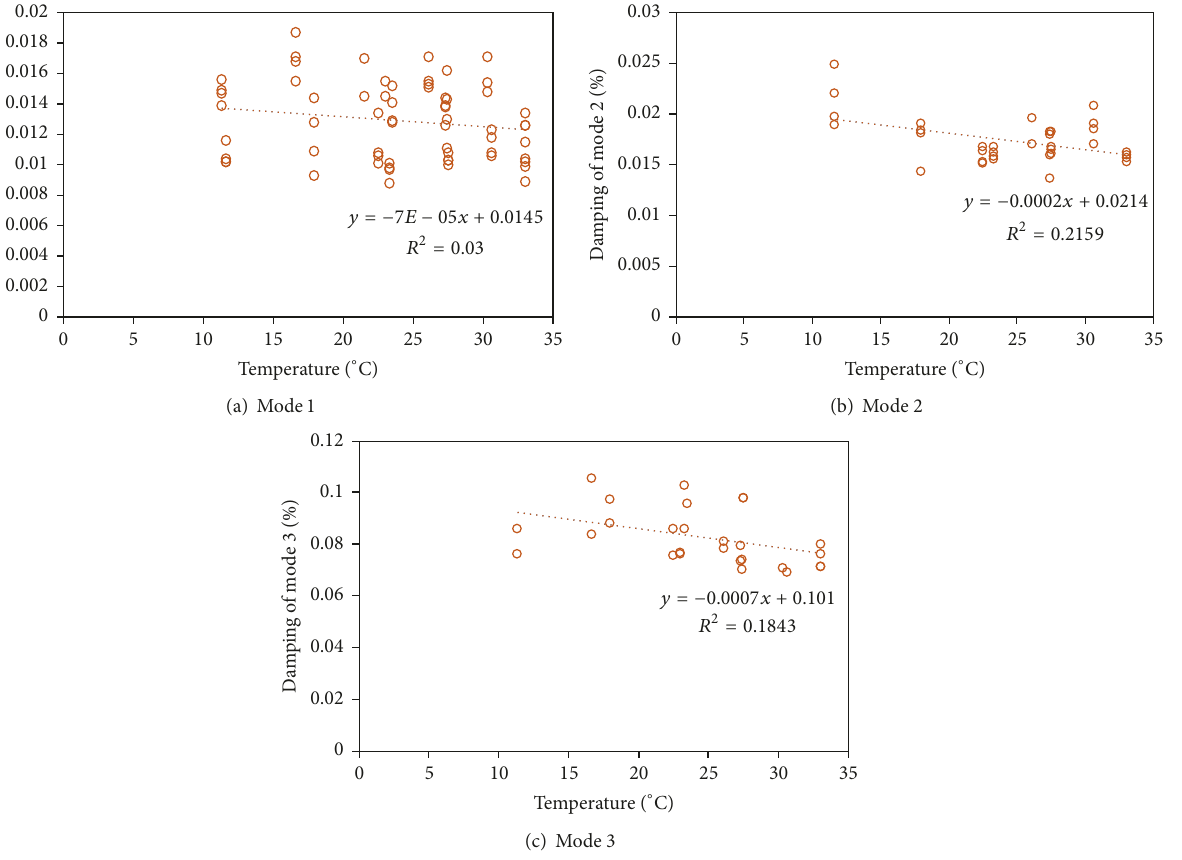
Figure 14: ((a)–(c)) Relation of damping ratios of girder No. 3 to temperature.